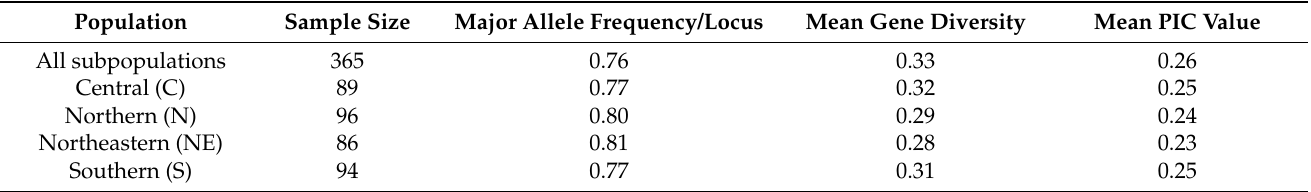
Table 2. The genetic diversity parameters of four subpopulations grouped by the four regions of Thailand.